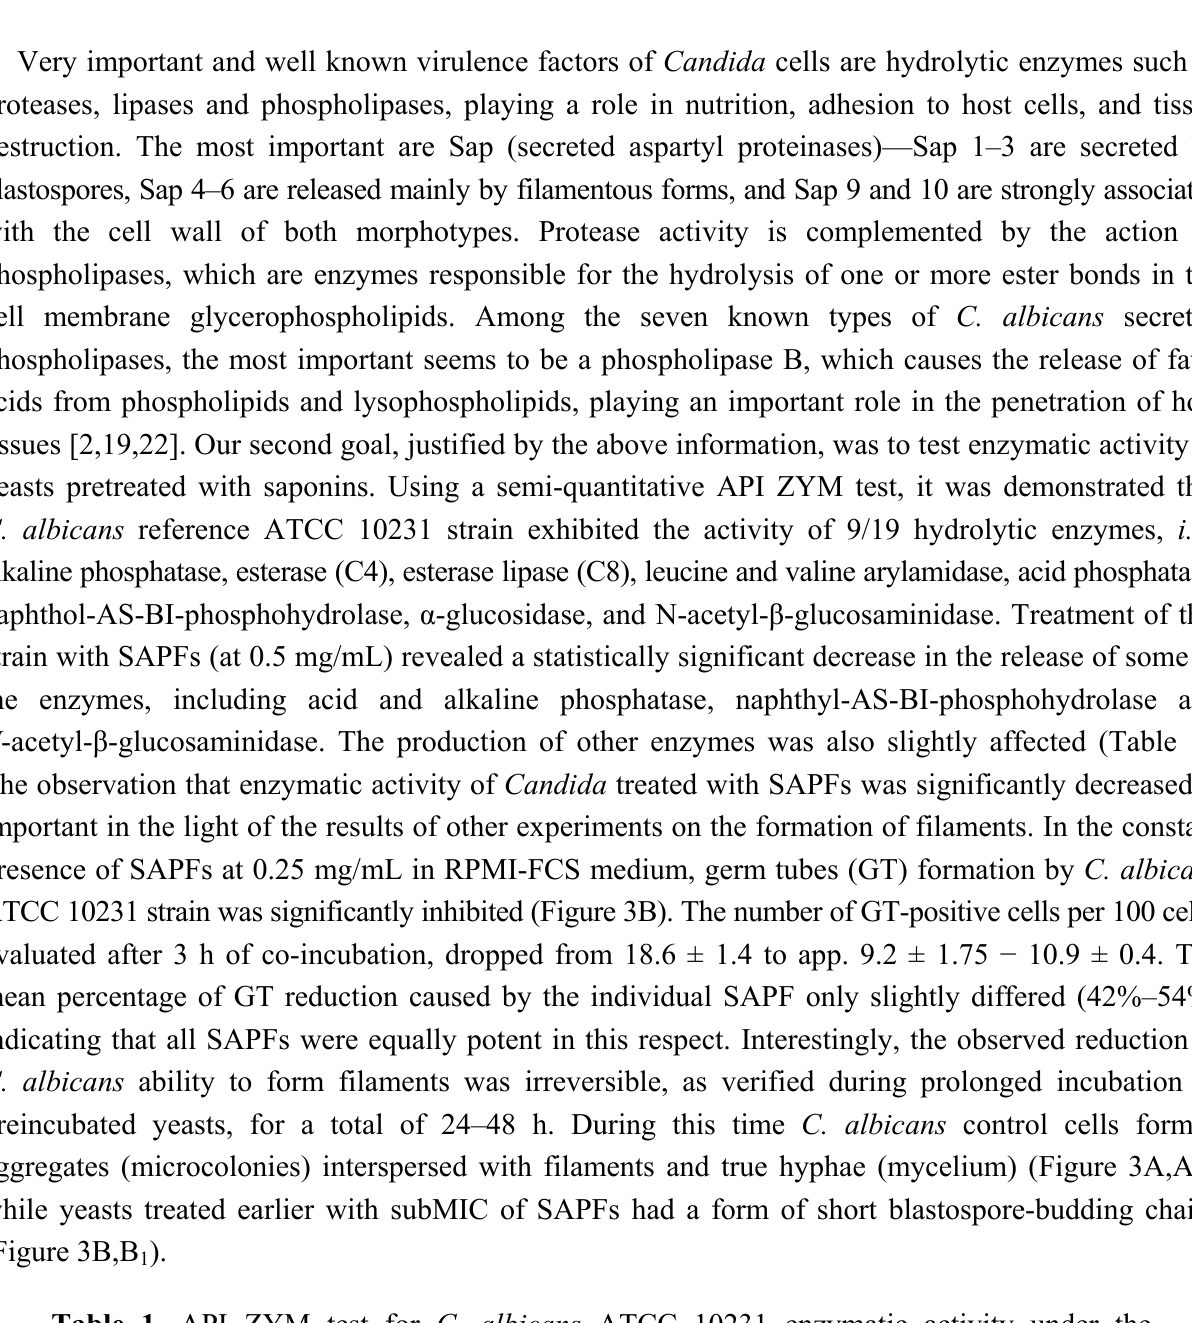
Table 1. API ZYM test for C. albicans ATCC 10231 enzymatic activity under the influence of Trifolium spp—derived SAPFs. The mode of phytocompounds action, used at subMICs (0.5 mg/mL) was as described in the Experimental